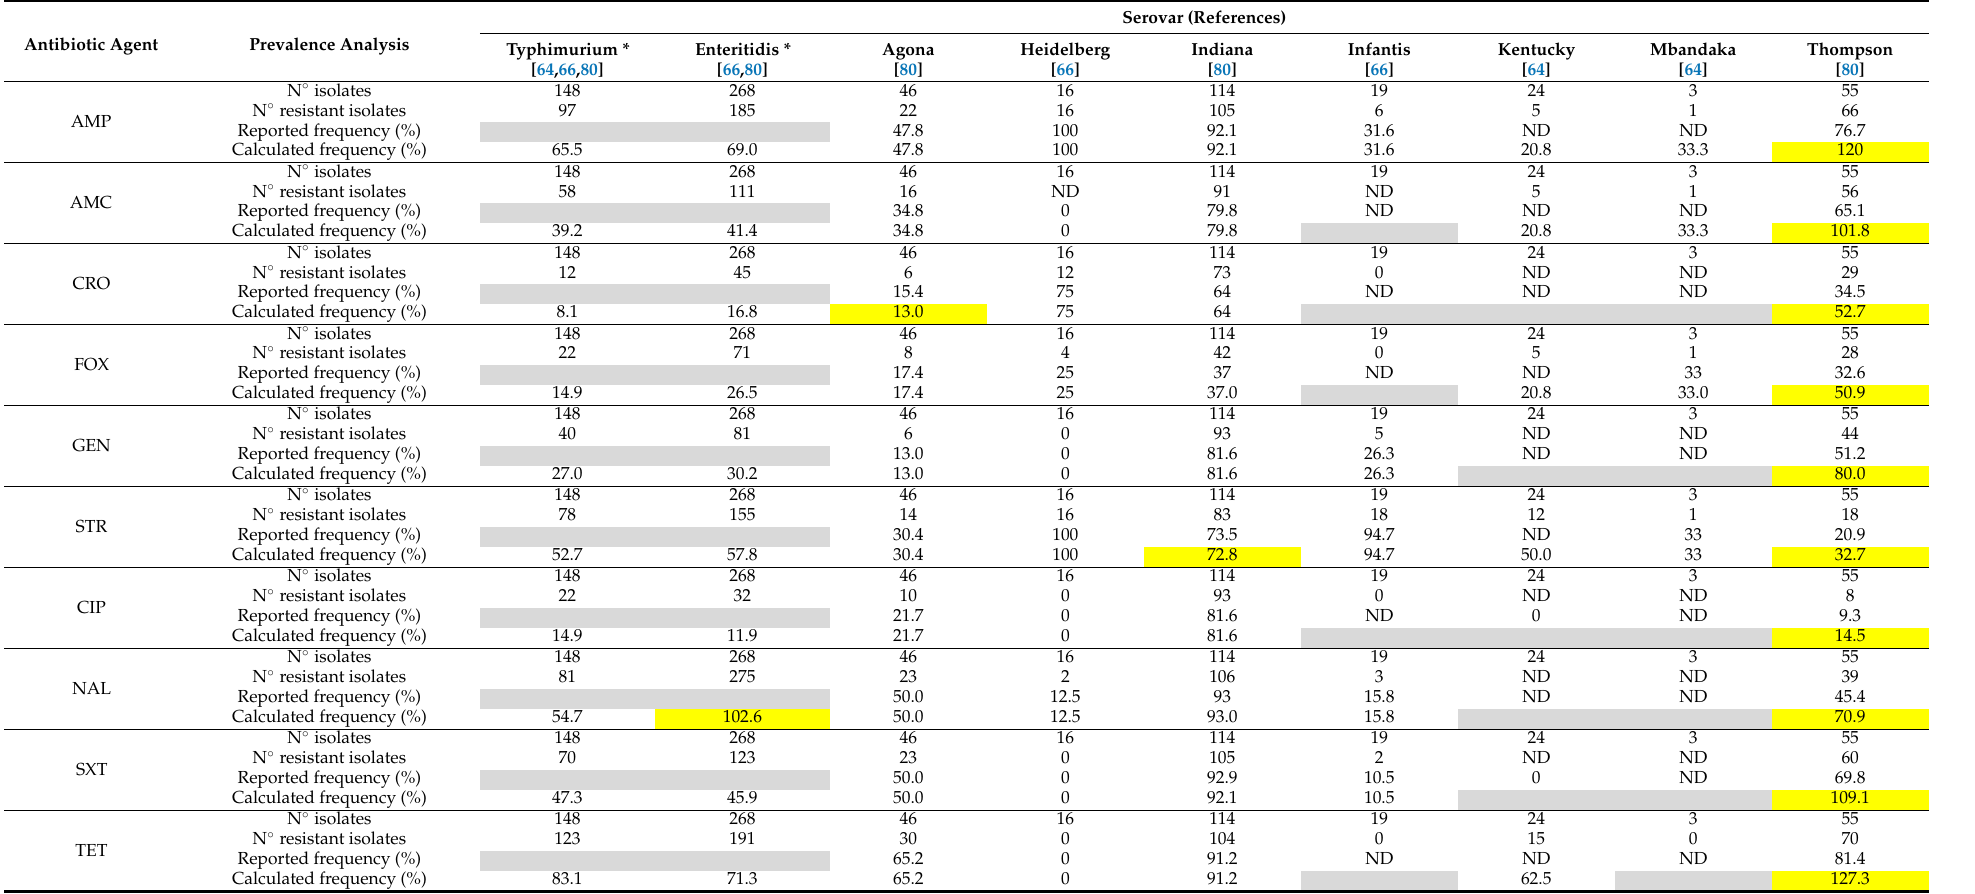
Table 2. Salmonella spp. antimicrobial agent frequency of resistance as determined by